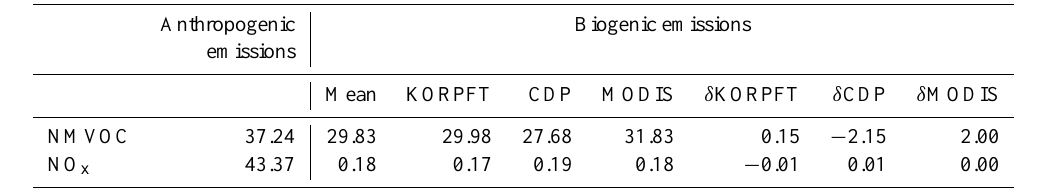
Table 2. Anthropogenic and biogenic nonmathane VOC (NMVOC) and NO x emissions and deviations between different PFT-input cases (unit: Ggperiod − 1 ) .